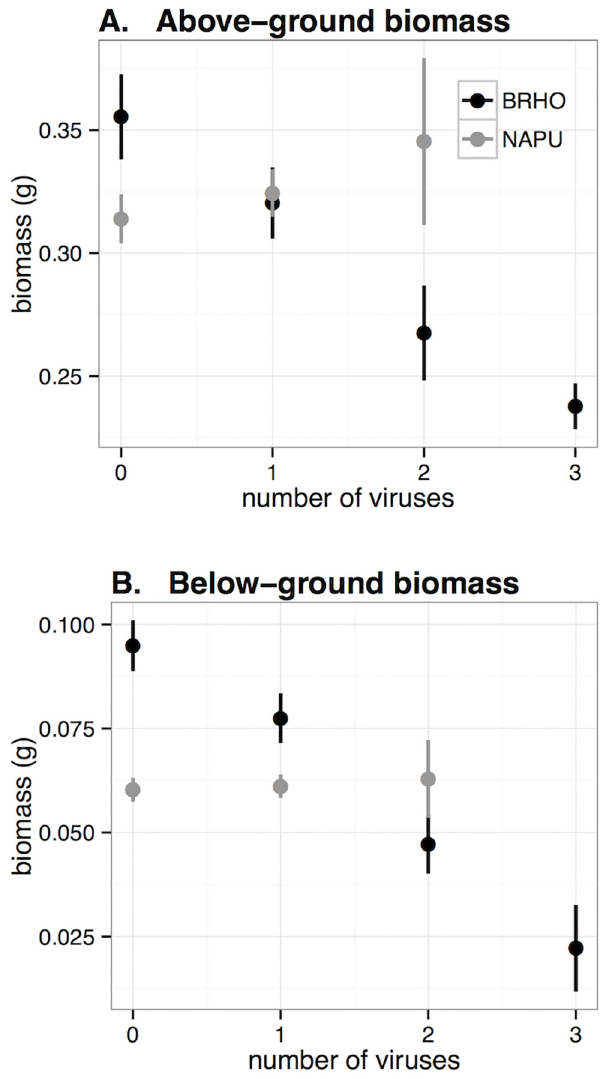
Fig 6. Above- and below-ground biomass versus number of viruses infecting a plant. A, above-ground biomass and B, below-ground biomass, both in grams. Black points are Bromus hordeaceus and gray points are Nassella pulchra . Data are from all plants in the experiment. Error bars are +/- 1 SE.